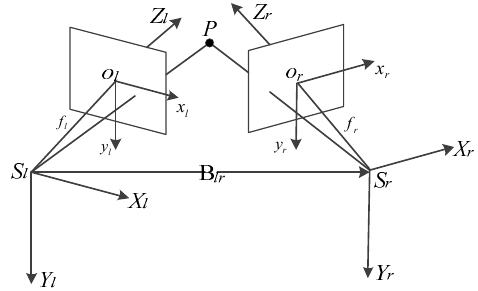
Figure 1. Stereo Vision System of Planetary Rovers.